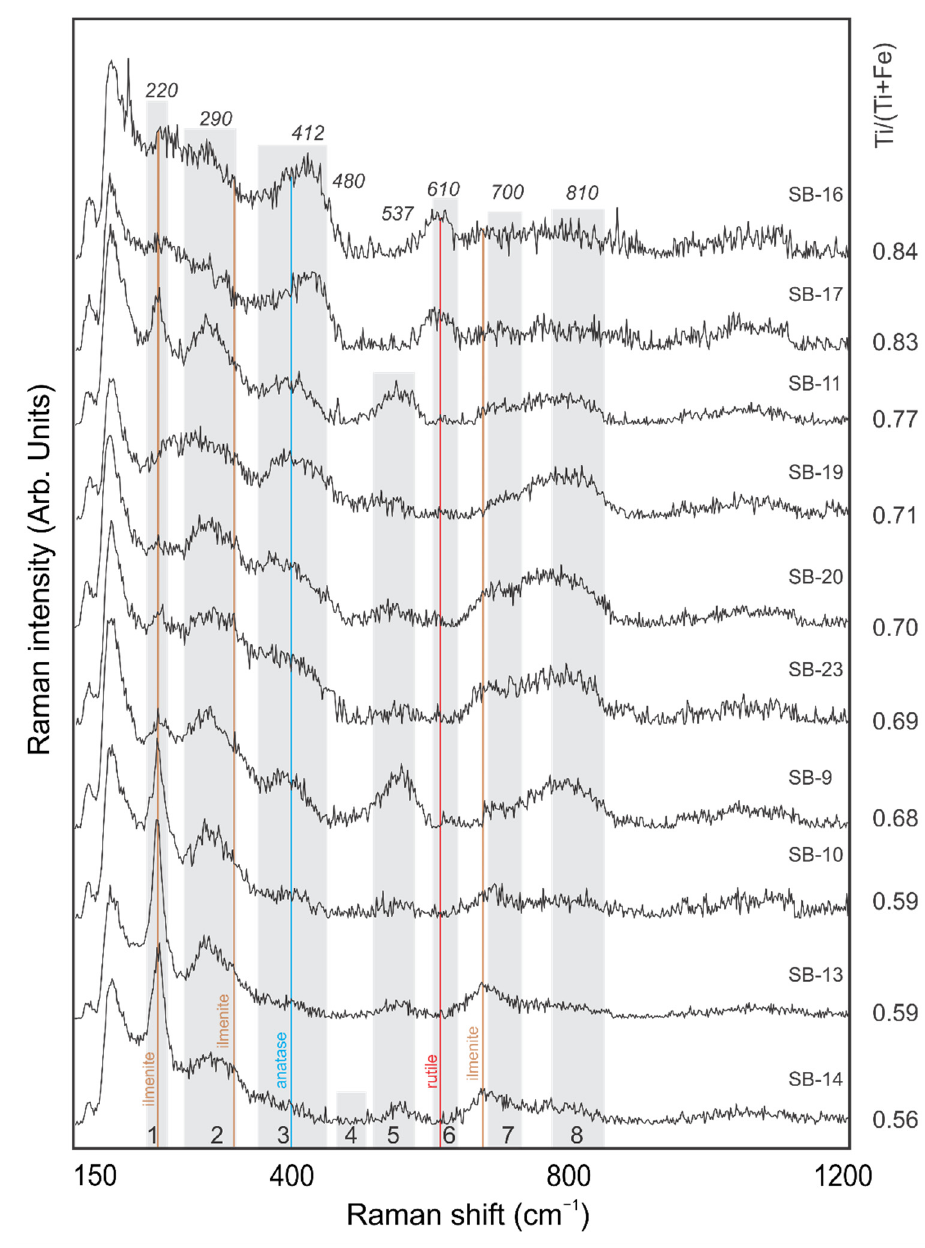
Figure 4. Raman spectra of Scotian Basin pseudorutile arranged based on increasing Ti/(Ti+Fe). Additionally, shows principal bands for ilmenite, anatase and rutile.